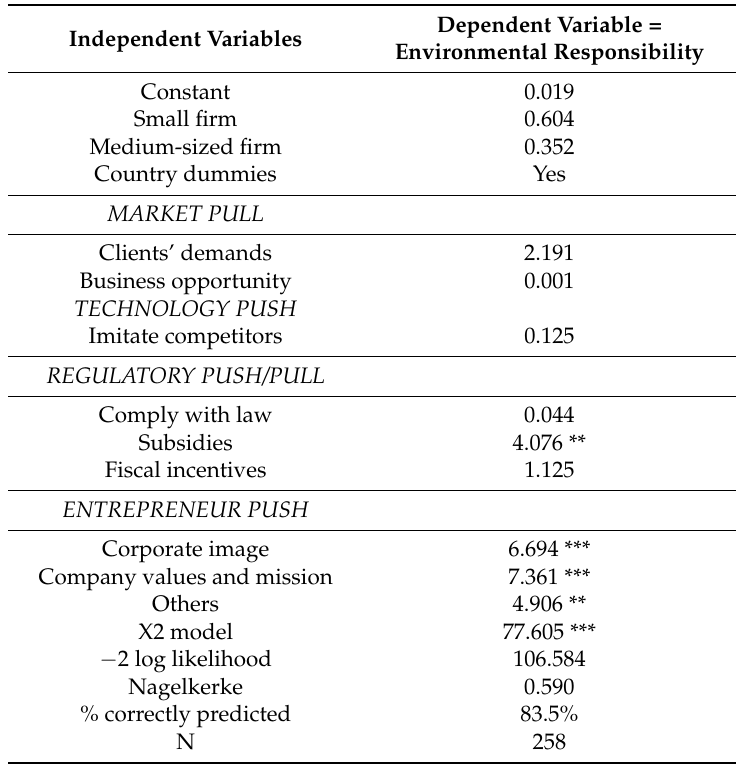
Table 2. Logistic regression model (Wald coefficients) of environmental responsibility in European SMEs within the water and waste management